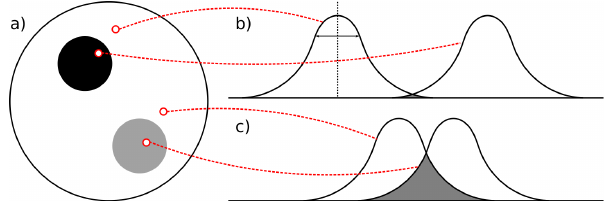
Figure 2. Tomogram showing two distinct circular features (a) . The Fig. 2 : Tomogram showing two distinct circular features (a). The first of these is very different first of these is very di ff erent from the background, resulting in a 1.png small overlap (b) of the associated probability distributions for the from the background, resulting in a small overlap of the associated probability distributions for two sampled points. The bottom feature is much closer to the back- Figure 1. A schematic representation of the two model patterns the two sampled points. The bottom feature is much closer to the background and has a larger ground and has a larger overlap (c) of the associated probability created for the validation of the tomography system. (a) centered Fig. 1 : A schematic representation of the two model patterns created for the validation of the overlap of the associated probability distributions for the two sampled points. distributions for the two sampled full ring pattern 1cm thick; (b) homogeneous particle distribution. tomography system. a) centered full ring pattern 1 cm thick; b) homogeneous particle distribu- tion.